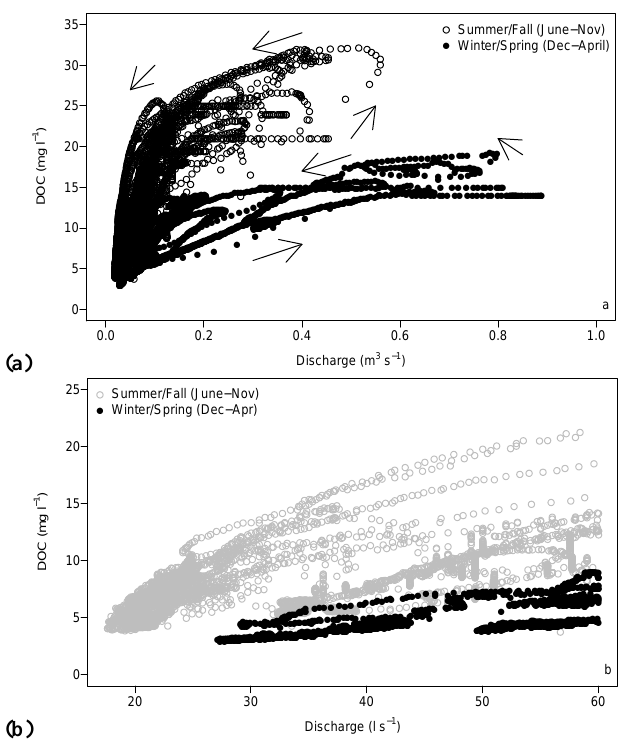
Fig. 3. (a) Counterclockwise hysteretic loops of DOC concen- trations in response to discharge for summer/fall, and for win- ter/spring. (b) DOC concentrations response at low discharge changes ( < 60Ls − 1 )